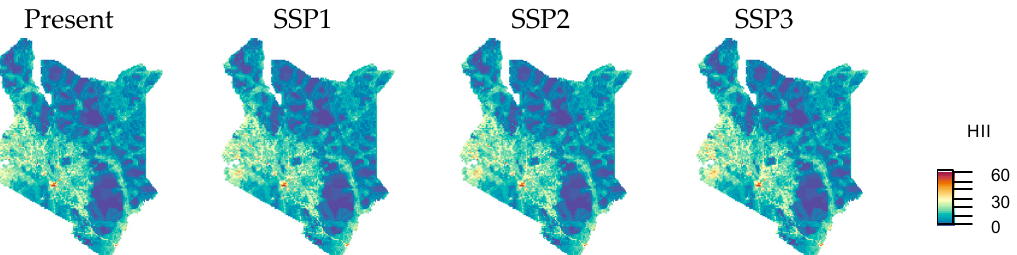
Figure 4. Present and projected urban area in 2050 according to population densities by SSPs.